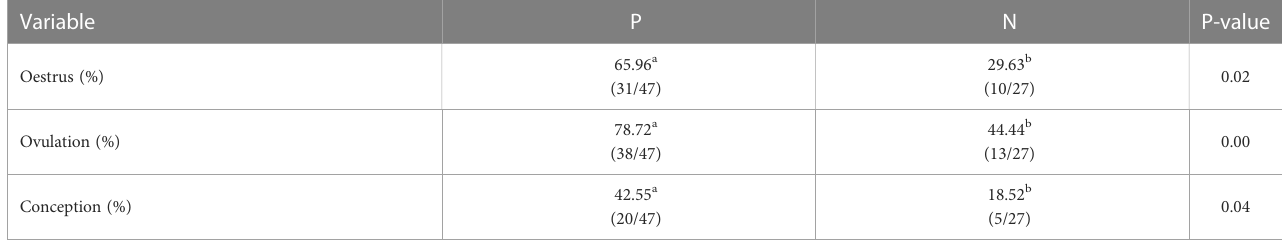
TABLE 5 Oestrus, ovulation and conception rates between antibody-positive and antibody-negative buffaloes.